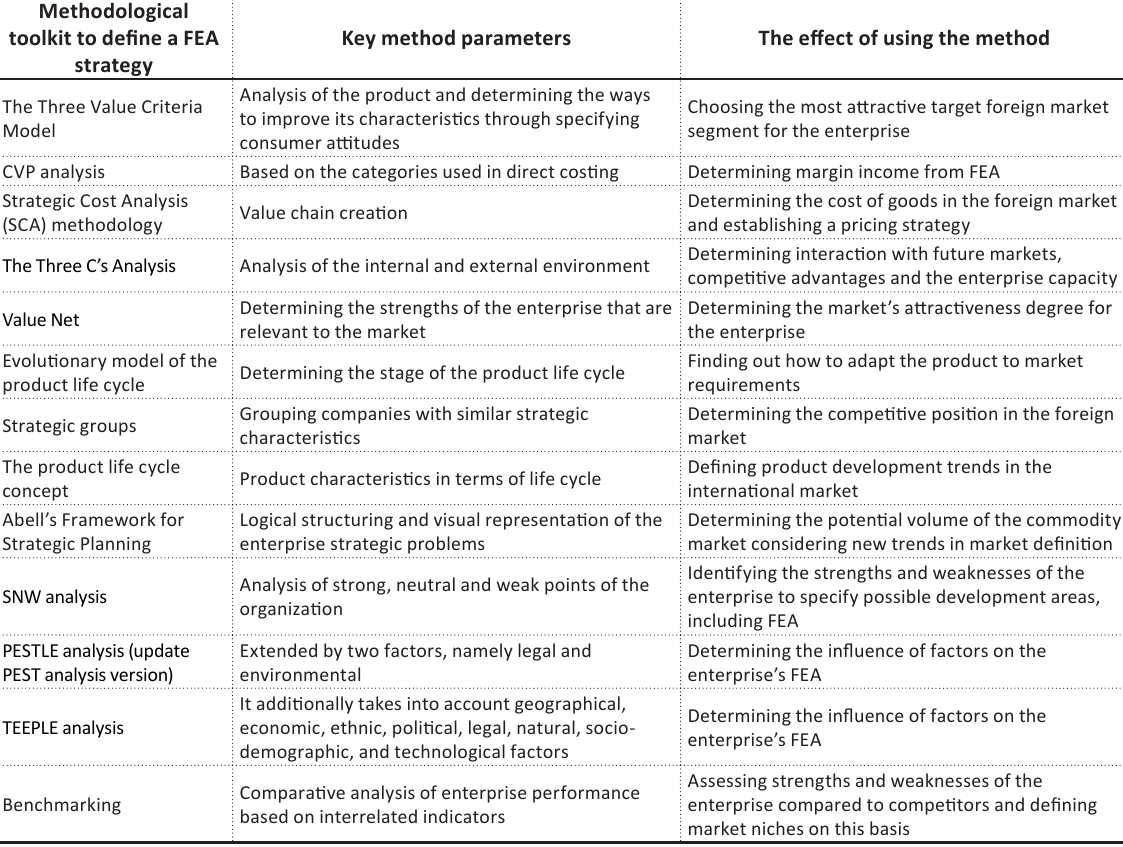
Table 1 (cont.). Methods of strategic analysis of the enterprise’s foreign economic